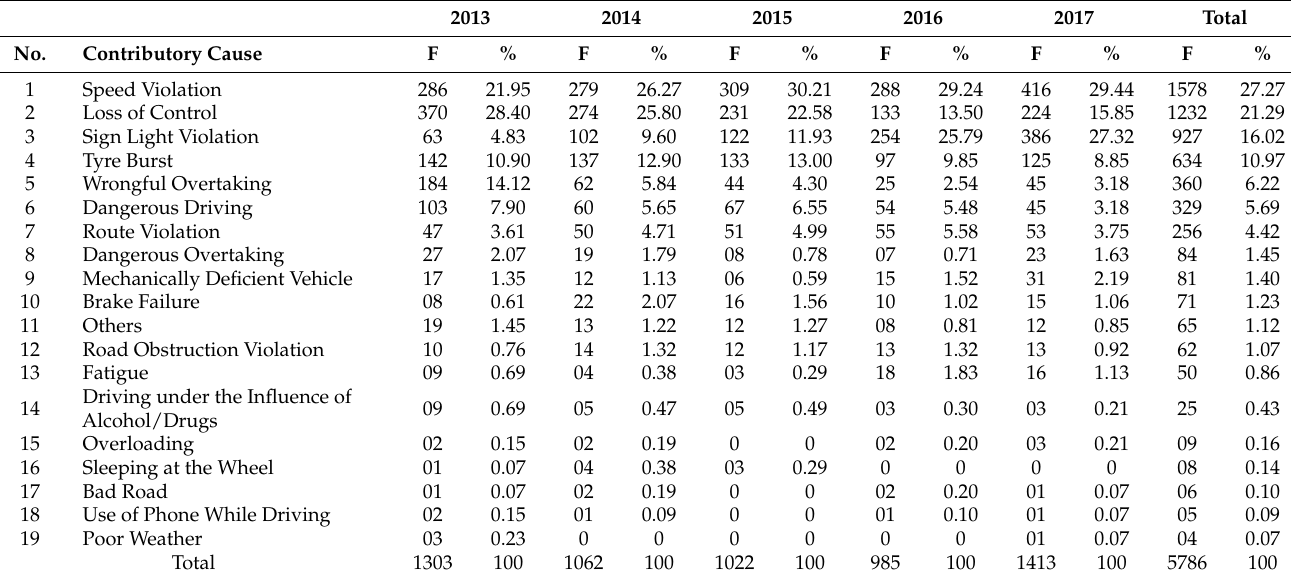
Table 2. Contributory causes of road traffic accidents along the Lokoja − Abuja − Kaduna highway (2013–2017).